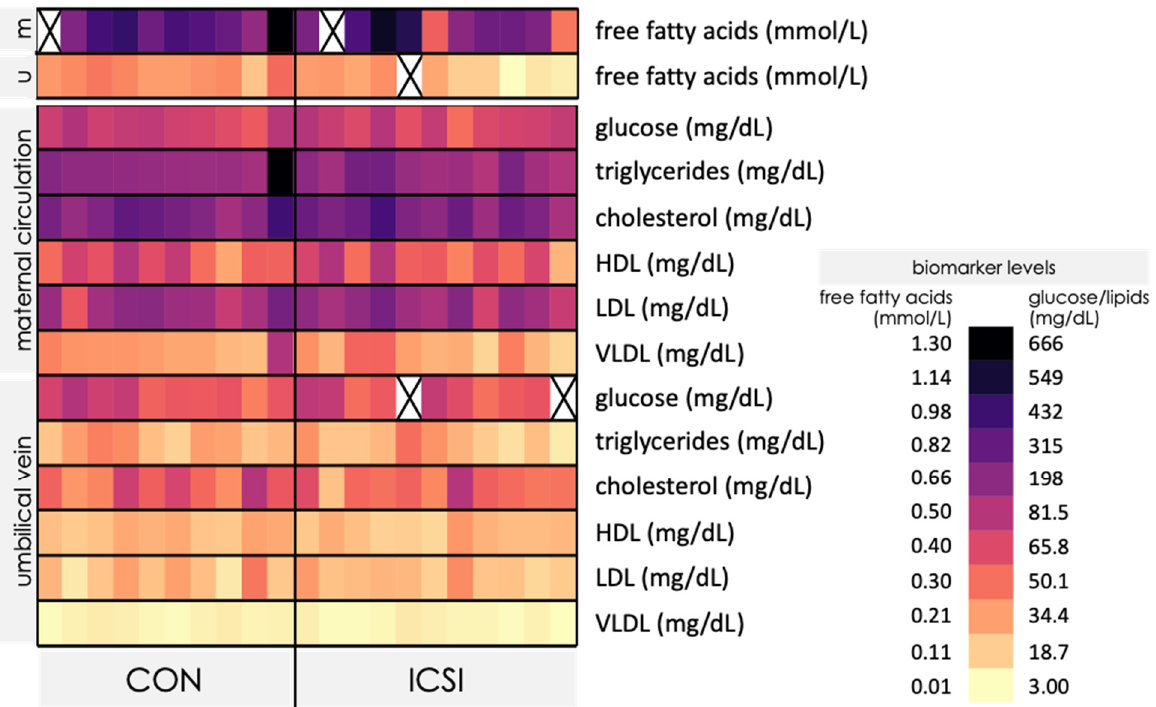
Figure 3. Heatmap of free fatty acids, glucose and lipid biomarker levels in maternal circulation and umbilical vein in control naturally conceived (CON; n = 10) and ICSI ( n = 11). Each column represents the nutrient profile of an individual pregnancy (maternal and umbilical vein). Darker colors indicate higher biomarker concentrations and lighter colors indicate lower biomarker concentrations. X = no value measured. Refer to supplementary Tables S1 and S2 for values. m = maternal circulation. u = umbilical vein.